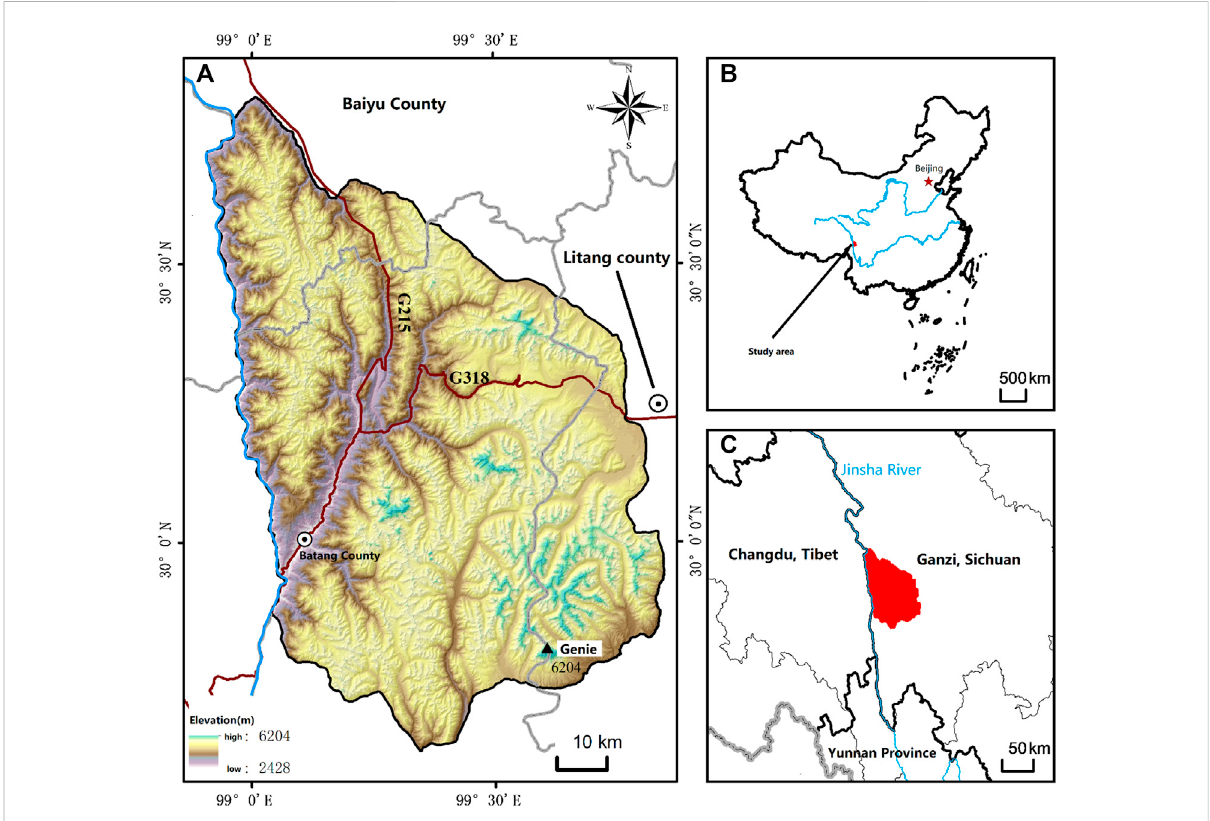
FIGURE 1 Topographic map of the study area (A) , location of the study area in China (B) and overview map of the study site in Sichuan Province, south- western China (C)